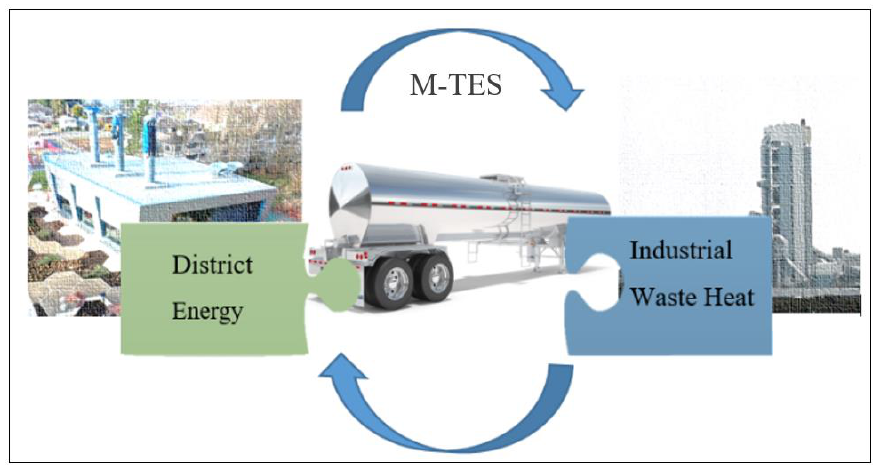
Figure 1. The concept design of mobile thermal energy storage (M-TES), the missing link, to move industrial waste heat to the District Energy Network.